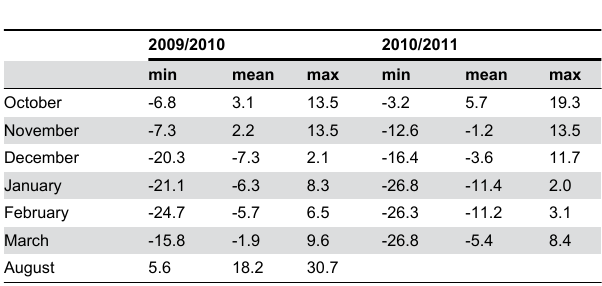
Table 1. Monthly minimal, mean and maximal temperatures (° C) recorded by weather station within the study